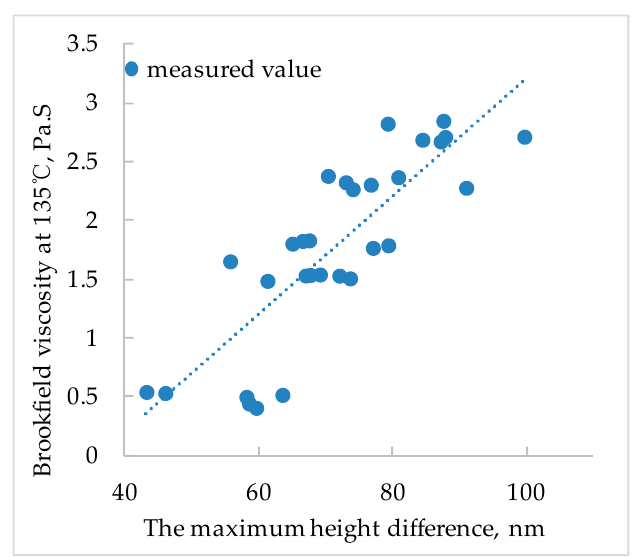
Figure 15. Relationship between Brookfield viscosity at 135 °C and the maximum height difference of SBS modified bitumen.